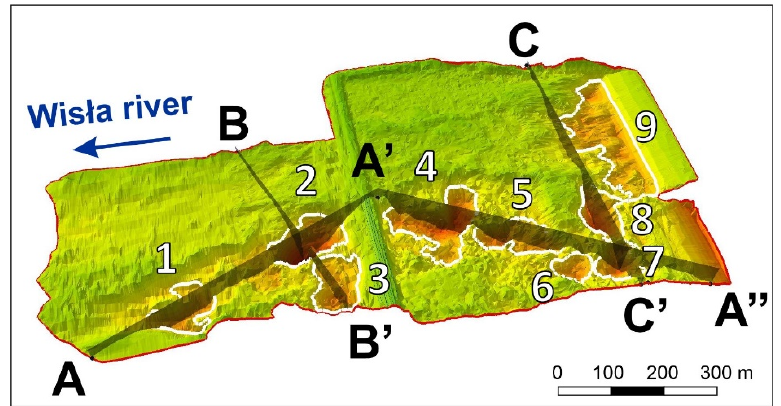
Figure 5. Study area. Potholes and cross sections.